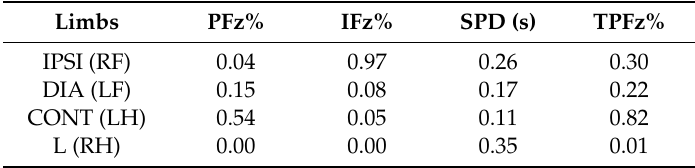
Table 4. The p values of PFz%, IFz%, SPD (s), and TPFz% comparing limbs between the groups. Limbs PFz% IFz% SPD (s) TPFz% IPSI (RF) 0.04 0.97 0.26 0.30 DIA (LF) 0.15 0.08 0.17 0.22 CONT (LH) 0.54 0.05 0.11 0.82 L (RH) 0.00 0.00 0.35